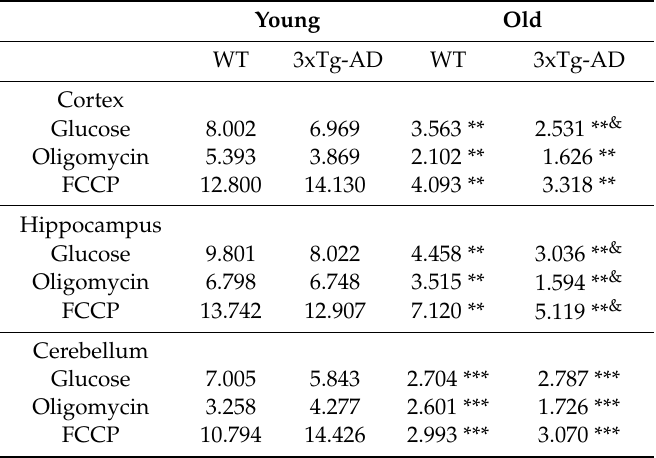
Figure 2. Age-related changes in oxygen consumption and mitochondrial membrane potential. Mitochondrial bioenergetics was measured in synaptosomes isolated from young and old female 3xTg-AD and WT mice. The oxygen consumption rate of cortical ( A ), hippocampal ( B ), and cerebellar ( C ) synaptosomes was measured in the presence of 10 mM glucose (white bar), 6 µ M oligomycin (gray bar), or 1 µ M FCCP (black bar). Values are expressed as nmol O 2 / min / mg protein and are the mean percentage ± SEM of duplicate measurements from 3 independent animals per group. Fluorescence changes in the mitochondrial membrane potential probe Safranin O in cortical ( D ), hippocampal ( E ), and cerebellar ( F ) synaptosomes are shown. Arbitrary units are the mean ± SEM from triplicate measurements of 3–4 animals per group. ANOVA and Tukey’s multiple comparison test, * p < 0.05; ** p < 0.01; *** p < 0.001. Student’s t test, & p < 0.05. Table 1. Oxygen consumption of synaptosomes from cortex, hippocampus, and cerebellum of female WT and 3xTg-AD mice (nmol O 2 / min / mg protein).